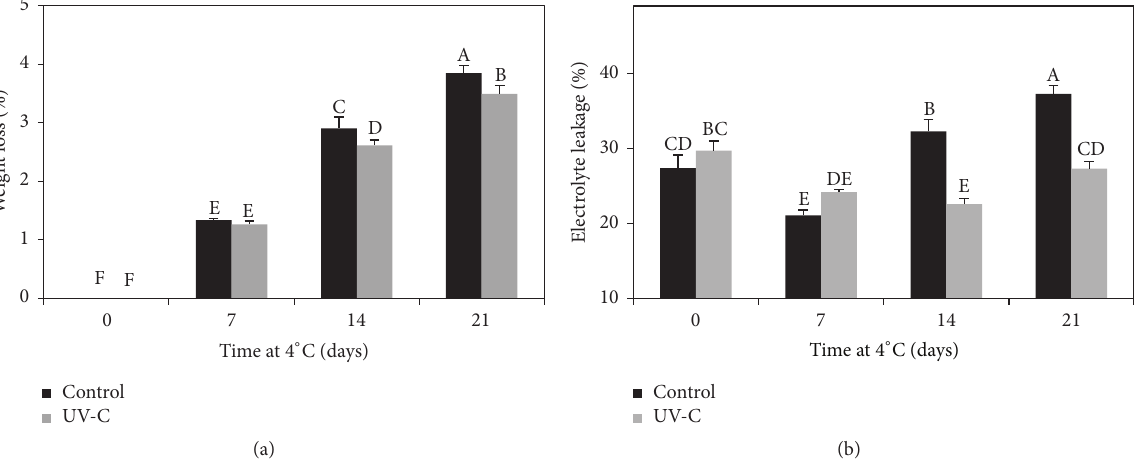
Figure 3: (a) Weight loss and (b) electrolyte leakage in control and UV-C treated (12.5kJ m −2 ) carambola slices stored for 0, 7, 14, and 21 d at 4 ∘ C. Bars represent the standard error ( 𝑛 = 3 ). Different letters indicate significant differences on Fisher’s test ( 𝑃 < 0.05